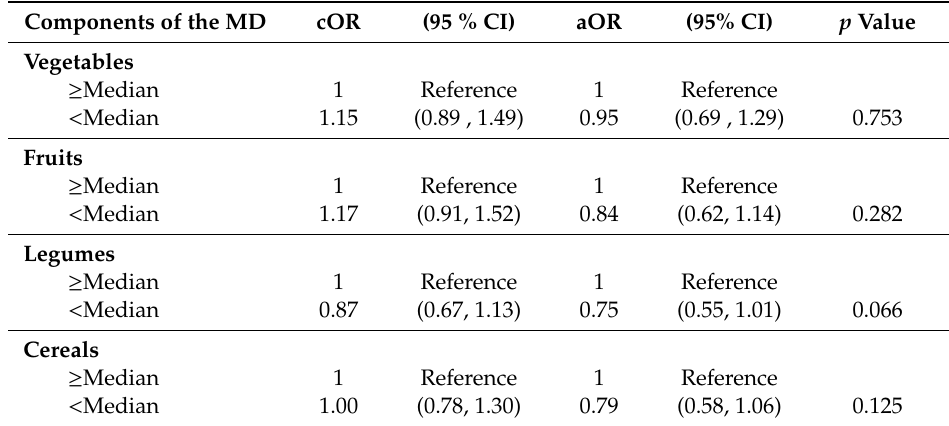
Table 3. Relationship between the components of the Mediterranean diet and the development of gestational diabetes